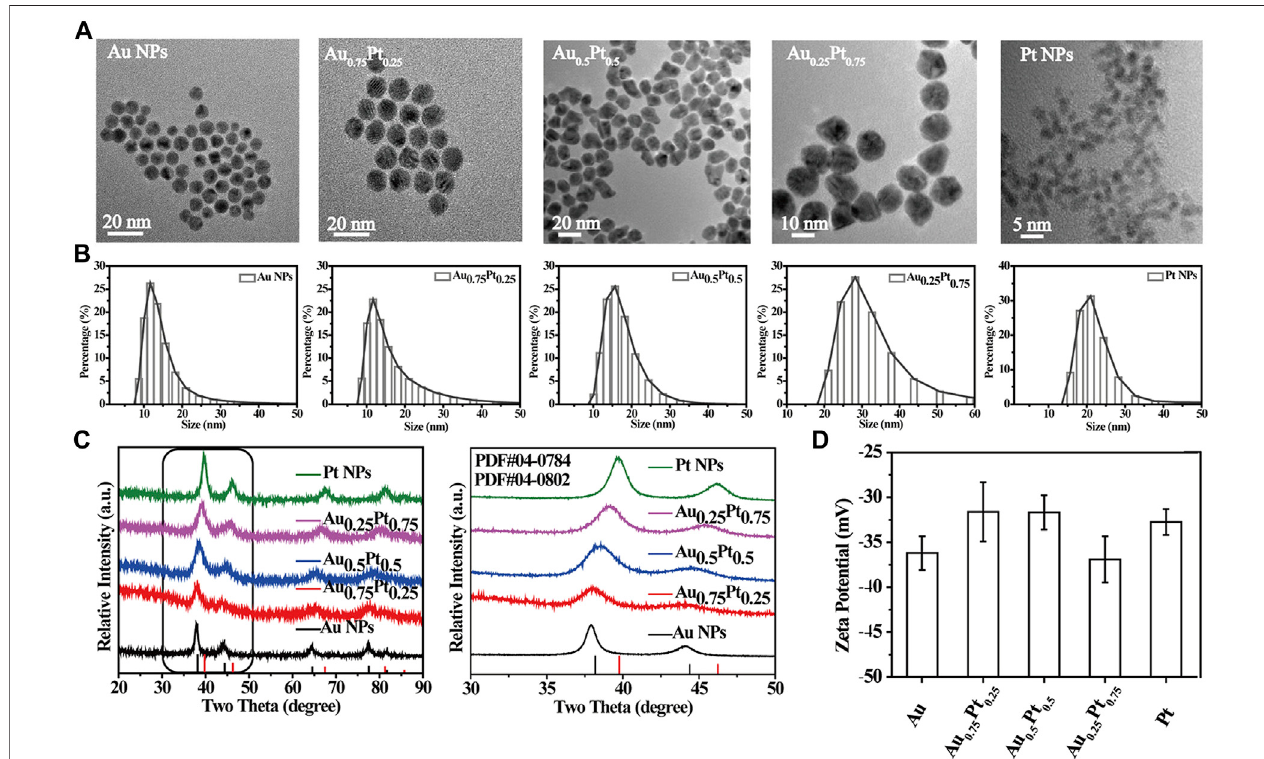
FIGURE1| CharacterizationofthepreparedAuPtalloys. (A) TEMimagesofAuPtalloyswithdifferentproportions. (B) HydrodynamicdiameterdistributionofAuPtalloys withdifferentproportions. (C) XRDpatternsofAuPtalloyswithdifferentproportions,partialenlargedXRDpatterns. (D) ZetapotentialofAuPtalloyswithdifferentproportions.